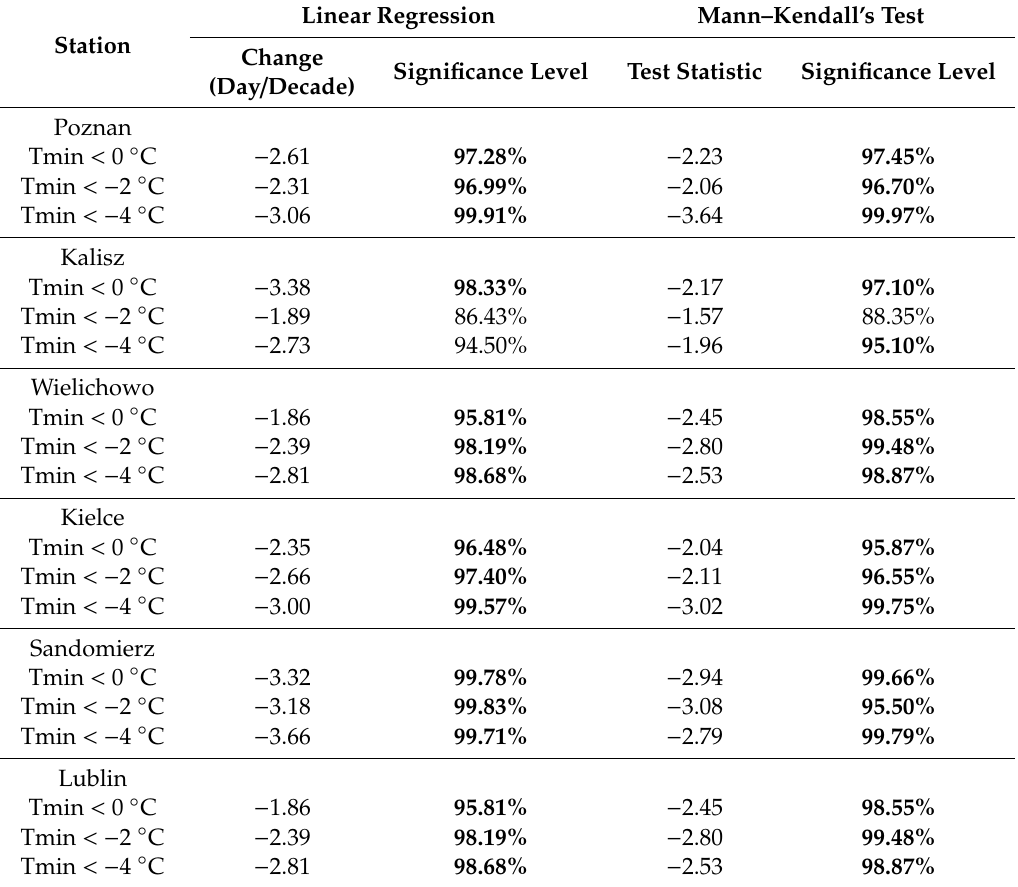
Table 3. Trend characteristics of the last spring ground frosts date in relation to the calendar year (1961–2020).